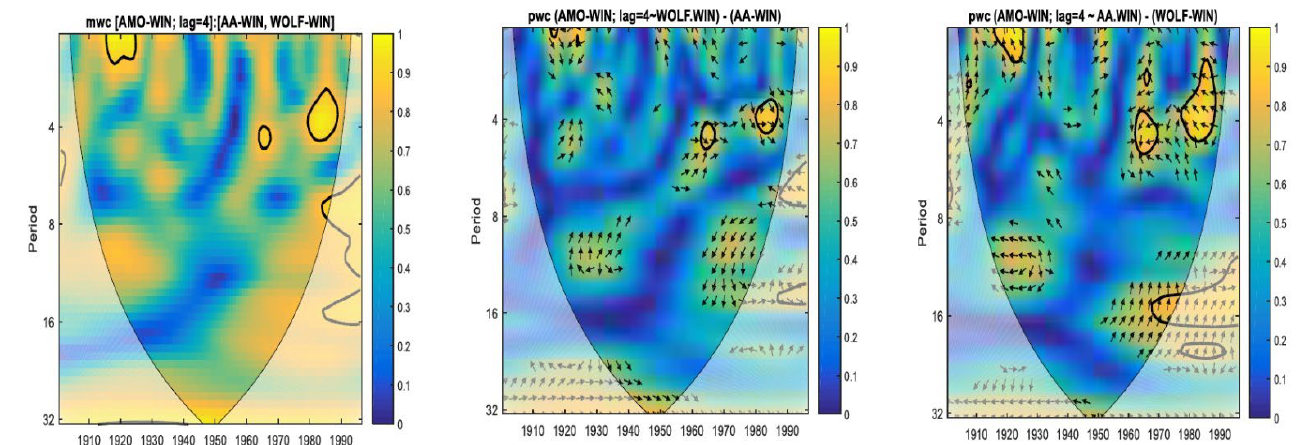
Figure 10. Left panel : Mwc between predictand (AMO) and the two predictors aa (AA) and WOLF number (WOLF) in wintertime, with lag = 4 years. Middle panel : pwc between AMO and WOLF number, eliminating the aa contribution. Right panel : pwc between AMO and aa , eliminating the Wolf number.